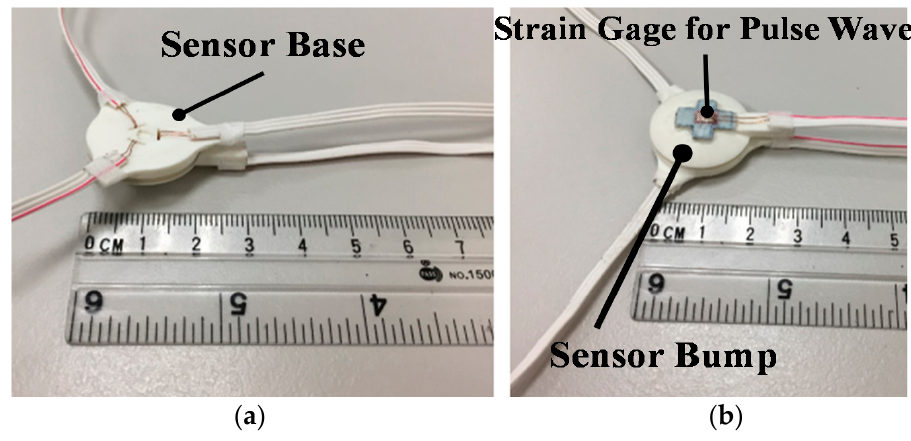
Figure 5. Photographs of the proposed strain-based pulse wave sensor. ( a ) Top of the sensor (through which the conducting wires are channeled). ( b ) Bottom of the sensor (where strain gauges are attached).